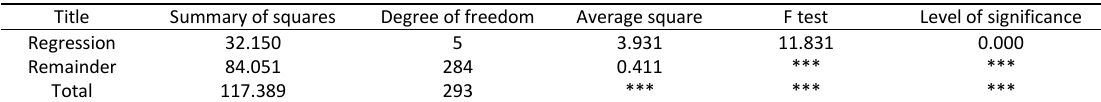
Table 7: Regression analysis of variance